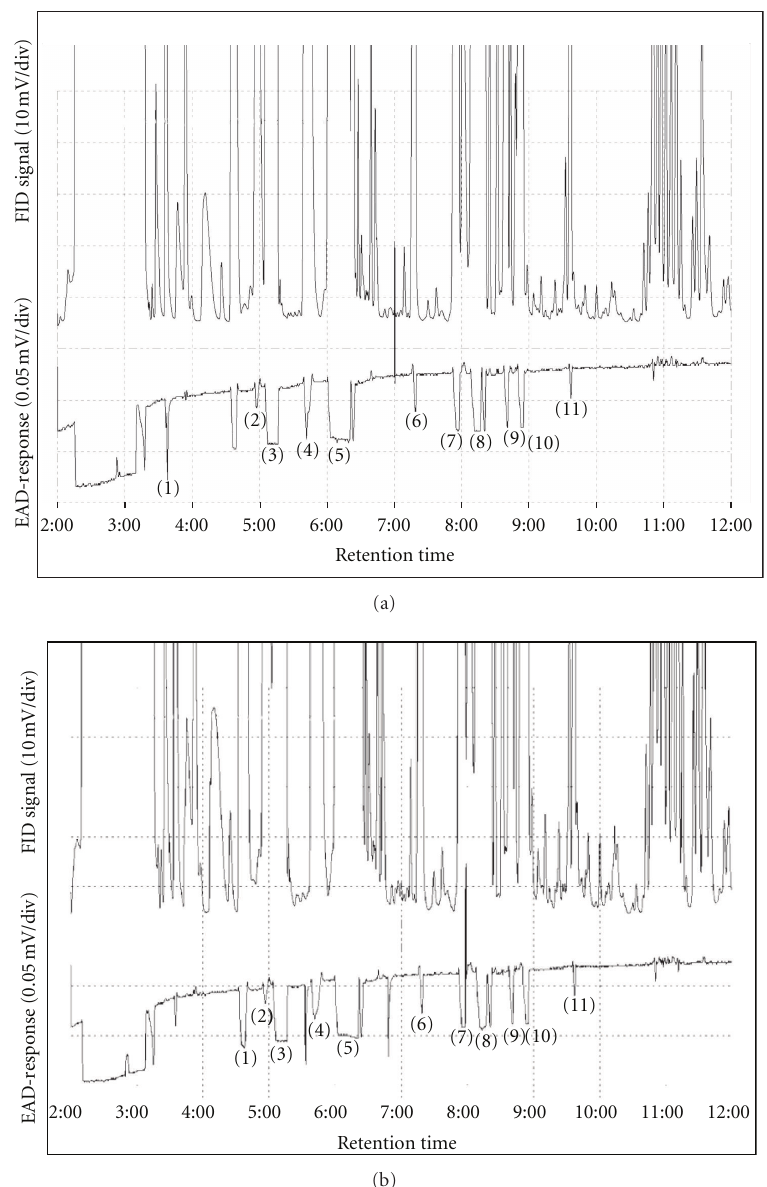
Figure 5: Eleven chemicals in fermented banana volatiles identified here, produced EAD-responses in olfactory organs of Morpho helenor . (a) Proboscis. (b) Foreleg, antenna, and midleg of Morpho helenor and the same organs of Caligo telamonius produced similar EAD- responses. (1) 2-Methylpropyl acetate. (2) Ethyl butanoate. (3) Butyl acetate. (4) 1-Methylbutyl acetate. (5) 3-Methylbutyl acetate. (6) Isobutyl isobutyrate. (7) Butyl butanoate. (8) Hexyl acetate. (9) 1-Methylhexyl acetate. (10) Butyl 3-methylbutanoate. (11) Pentyl